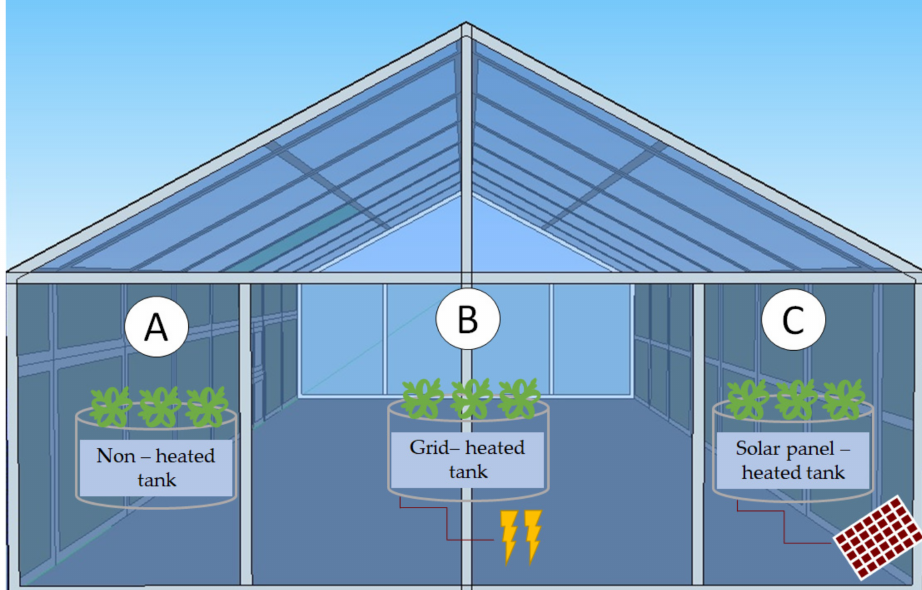
Figure 1. Experimental setup: rocket plants were grown inside hydroponic tanks with non-controlled (Tank A) and controlled (Tanks B and C) RZT. The difference between the two tanks with controlled RZT was the source of electrical power: solar panels vs. standard power